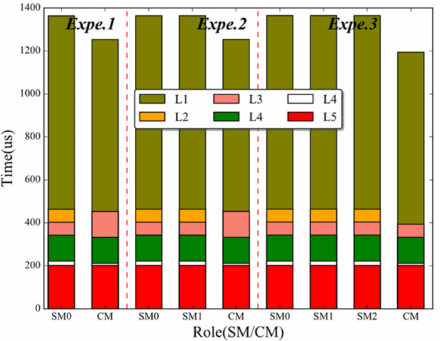
Figure 8. The time used by the nodes during the startup phase.